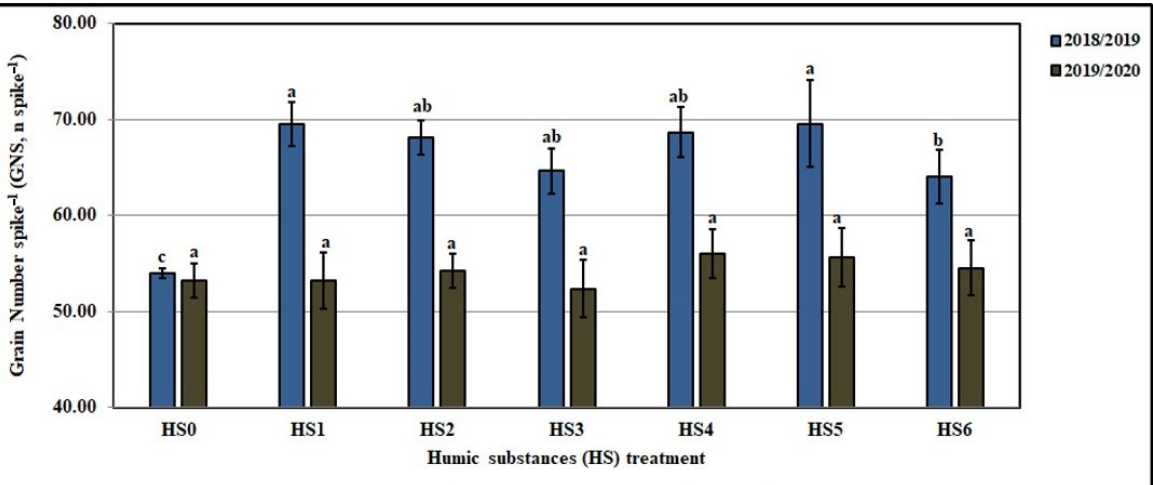
Figure 9. Influence of humic substances treatments on grain number per spike (GNS, n spike − 1 ) of some wheat varieties grown in clay loam soil in 2018/2019 and 2019/2020 seasons. Bars in the same years with a different letter indicate significant differences between treatments at p ≤ 0.01. HS 1, HS 2 , HS 3 represent HS applied as foliar spray at 1.0, 2.0, 4.0 g L − 1 , respectively, HS 4 , HS 5 , HS 6 represent HS applied as soil application at 5.04, 7.56, 10.08 kg ha − 1 .